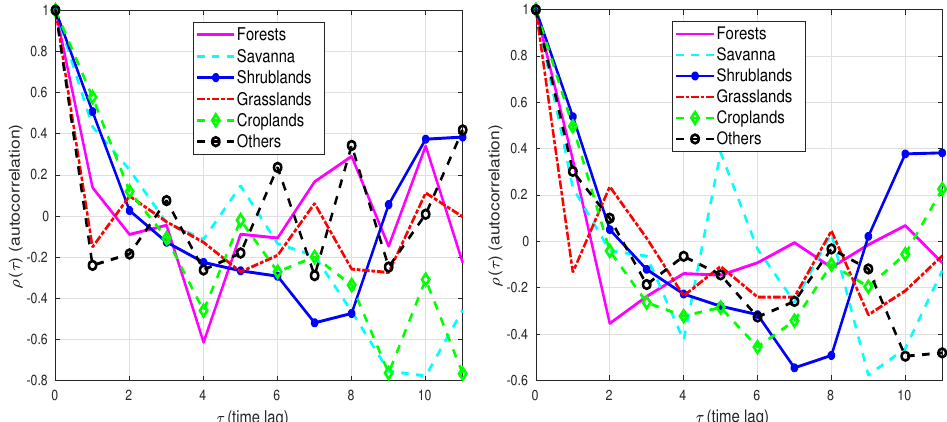
Figure 9. Graphs of autocorrelation as a function of the time lag applied to the time series of the proportion of the burnt area for different vegetation types in ( left ) southern-hemisphere Africa and ( right ) northern sub-Saharan